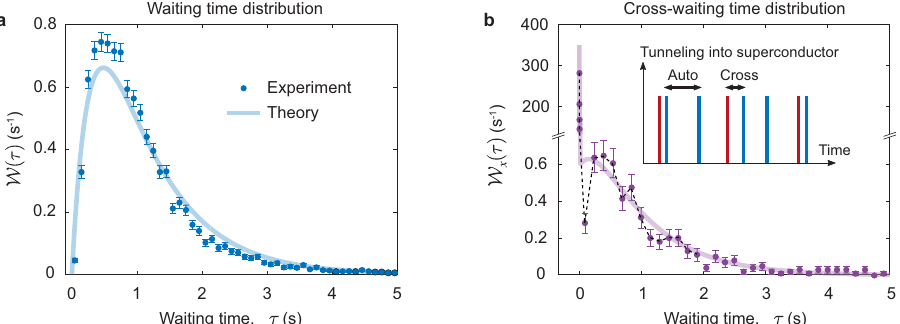
Fig. 3 Waiting-time distributions W . a Waiting times τ between single-electron tunneling out of the right island. The theory curve given by Eq. (3) agrees well with the measurements. b Waiting times τ between single-electron tunneling out of the left island followed by single-electron tunneling out of the right island. Note that the peak at the short times is more than two orders of magnitude higher than the long time data. The experimental data is well-captured by Eq. (4). The dashed line serves as a guide to the eye. The inset illustrates the waiting times between tunneling events of the same or different types. The blue lines correspond to tunneling out of the right island, while the red ones correspond to the left island. The error bars mark 1 σ con fi dence